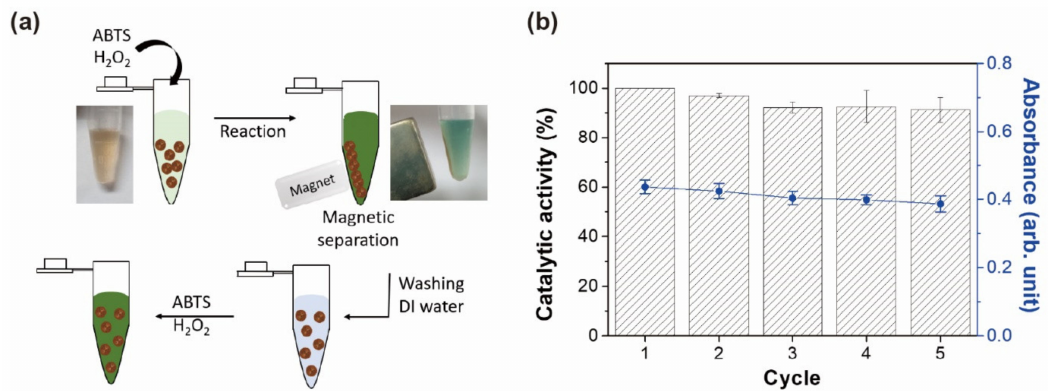
Figure 4. Catalytic activity of reusable magnetic hydrogels. ( a ) Initial use and subsequent reuse of magnetic hydrogels for detecting H 2 O 2 -mediated reactions. ( b ) Catalytic activity of magnetic hydrogels after multiple cycles of assay reaction and magnetic separation. Absorbance at 417 nm was used to calculate the catalytic